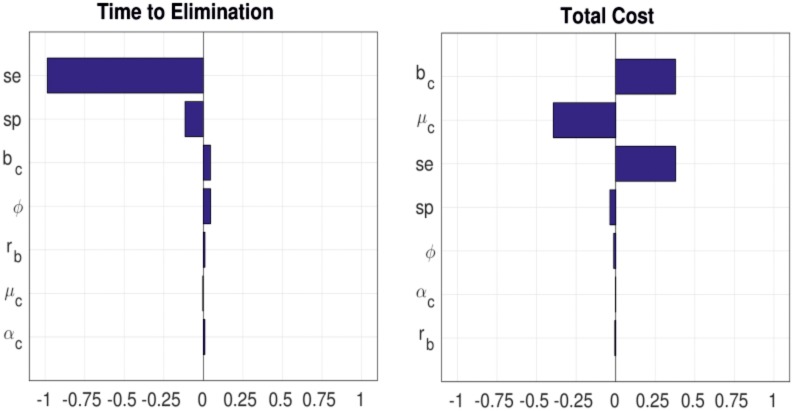
Partial rank correlation coefficients (PRCC) sensitivity analysis of time to elimination (left) and total cost (right) on parameter values.